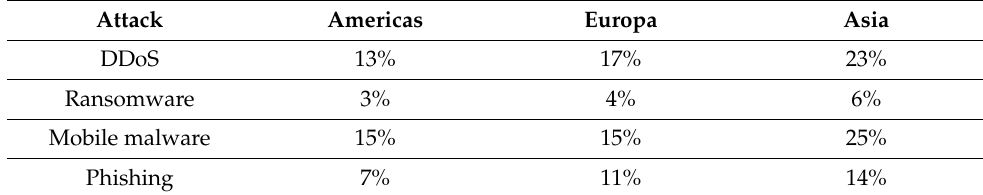
Table 4. Growth rate percentage of cyberattack 2020.